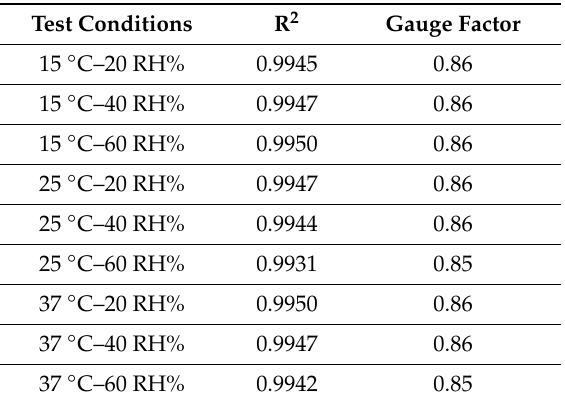
Table 2. Sensor capacitive gauge factor (G) and linearity at di ff erent temperature and humidity, assessed over the linear range (~3 to 47%